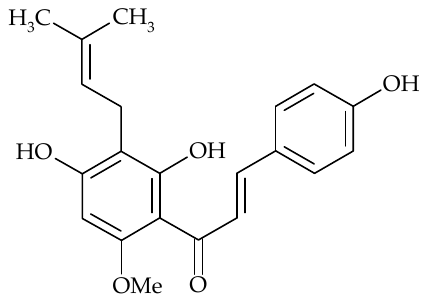
Figure 8. Chemical structure of xanthohumol.